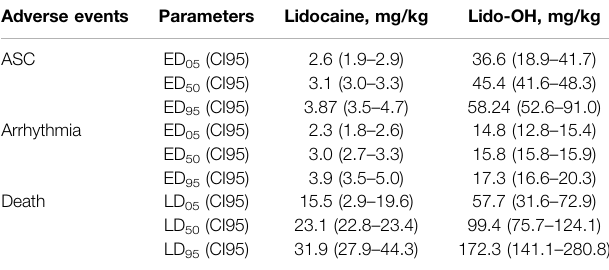
TABLE 1 | Equivalent doses for central nervous system toxicities, cardiac toxicities, death, and tail nerve block in mice. Adverse